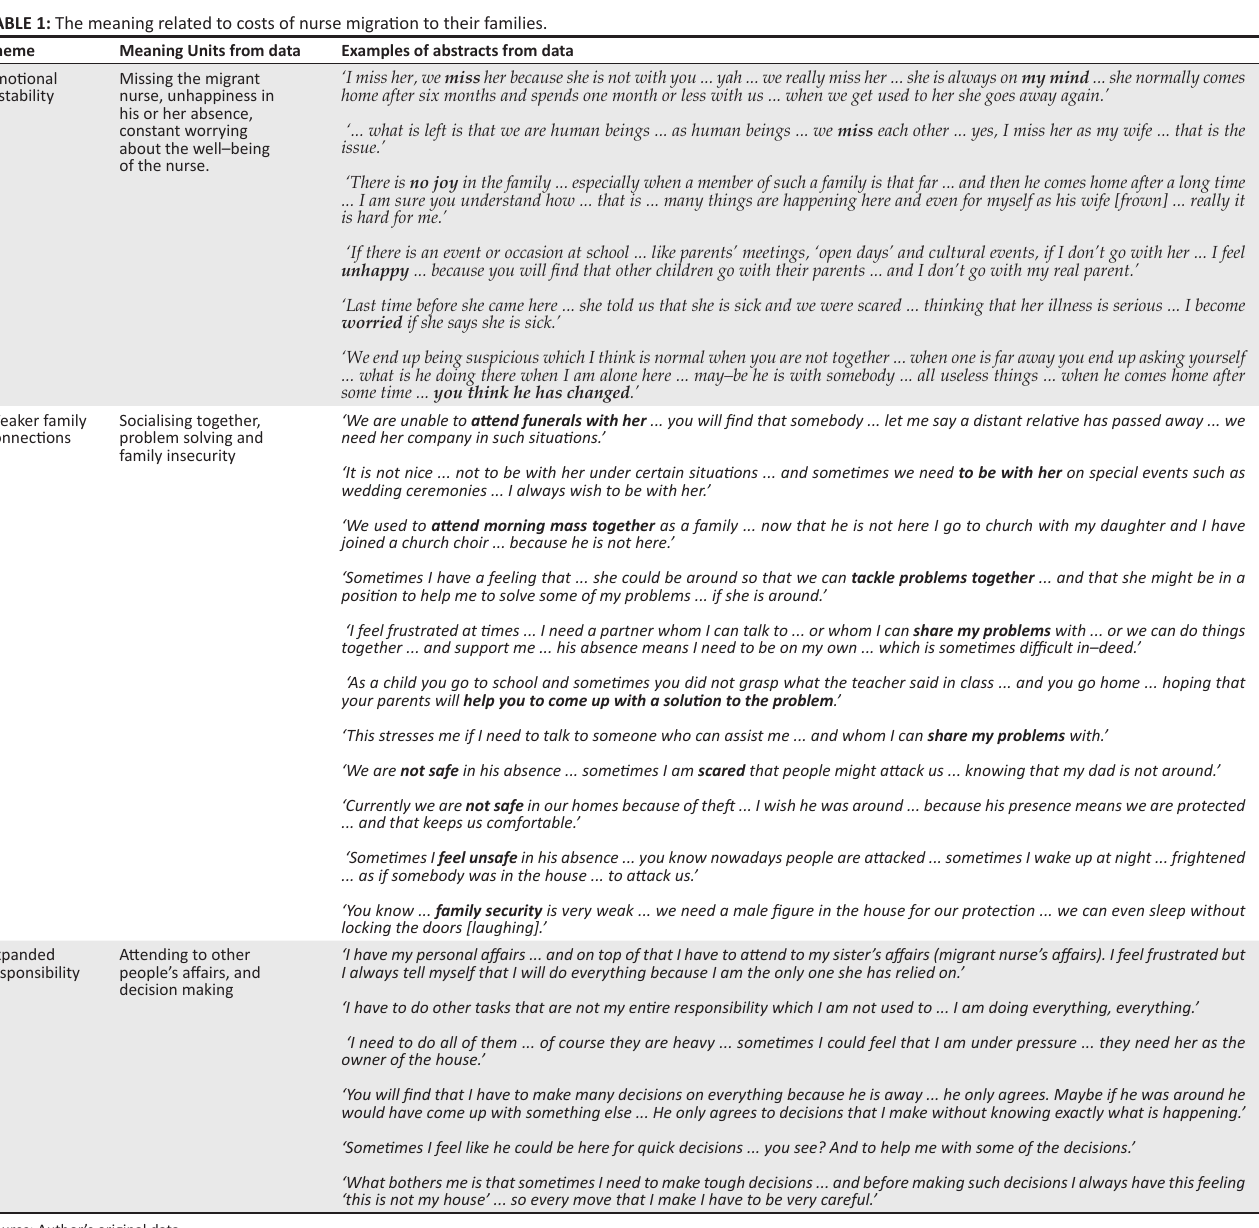
TABLE 1: The meaning related to costs of nurse migration to their families. Theme Meaning Units from data Examples of abstracts from data Emotional